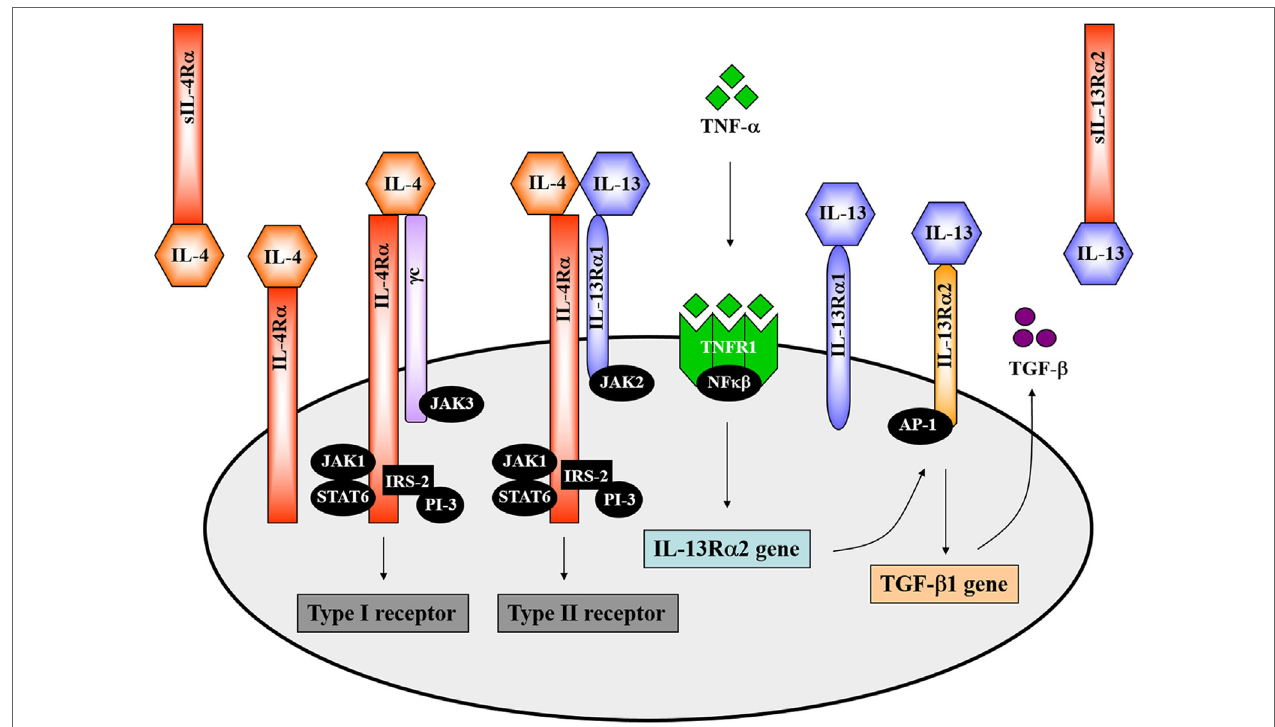
FiGURe 1 | The interleukin-4 (IL-4) and interleukin-13 (IL-13) receptor complexes. IL-4 interacts with the interleukin-4 receptor alpha (IL-4R α ) chain in combination with either the gamma common ( γ c) chain to form the type 1 receptor or with the IL-13-binding receptor alpha 1 (IL-13R α 1) to form the type 2 receptor complex. The IL-4R α chain signals via the JAK1/STAT6 pathway. Definitively, JAK3 associates with the γ c chain and JAK2 with the IL-13R α 1. IL-13 interacts with the type II receptor complex (through IL-13R α 1) or with the α 2 chain of the IL-13 receptor (IL-13R α 2). A signaling pathway for IL-13 via IL-13R α 2 has recently been identified. TNF- α induces upregulation of IL-13R α 2 expression. IL-13 then binds to the IL-13R α 2, which activates AP-1 to induce gene expression and secretion of soluble TGF- β . Illustration adapted and redrawn from previous publications (12, 34, 42, 52,